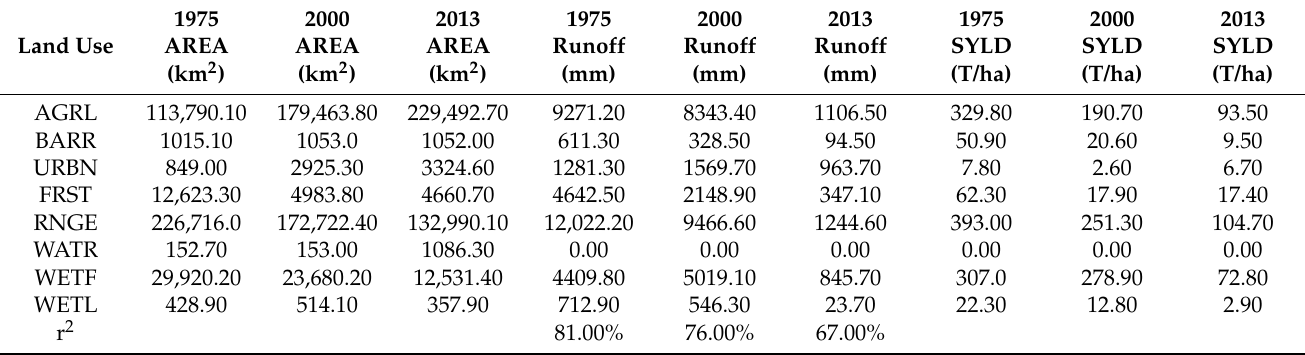
Table 6. Relationship between land use type sizes and sediment yield in the study area. Note the consistent higher runoff (mm) and sediment yield (T/ha) values in rangeland (RNGE) compared to agriculture (AGRL) regardless of its smaller sizes across the three years. Note also that the tabulated values are average annual values for the simulation